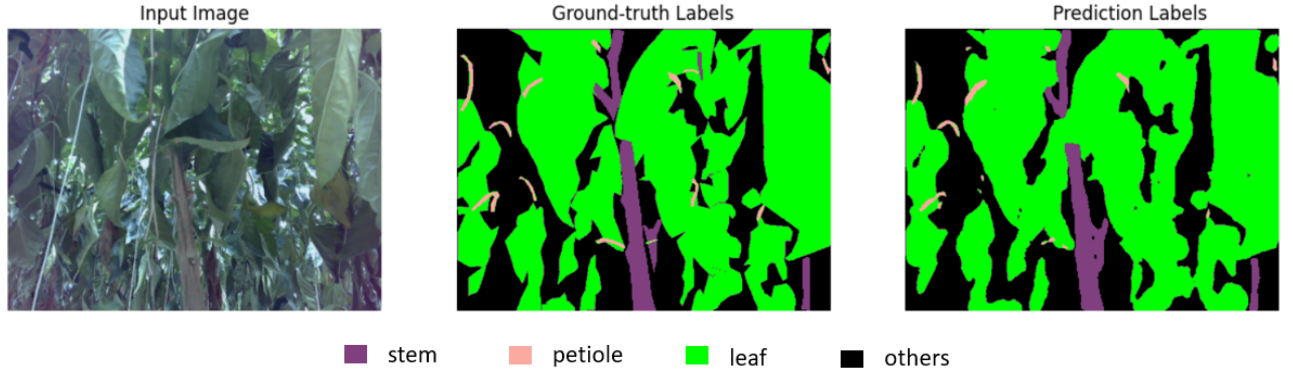
Figure 3. The prediction result of the model on the sweet pepper plant.